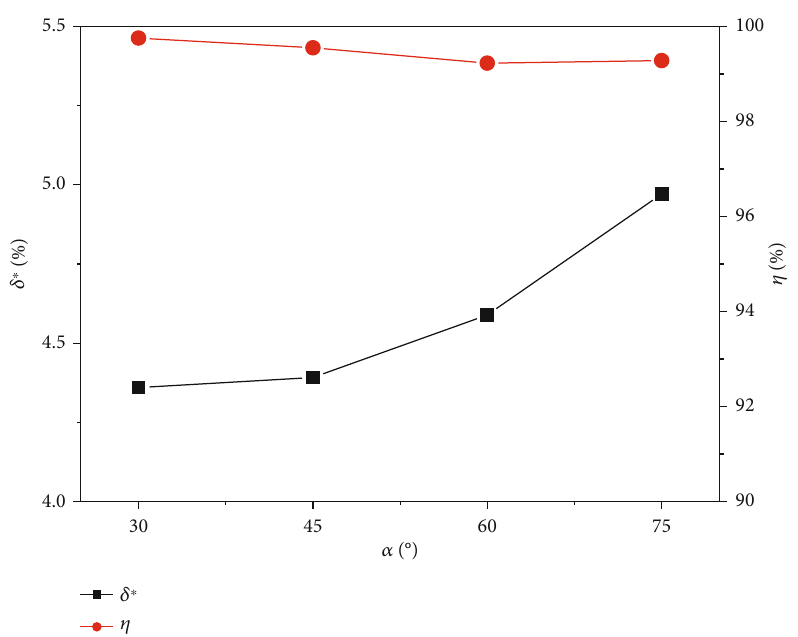
Figure 6: Total pressure loss and combustion e ffi ciency under di ff erent α